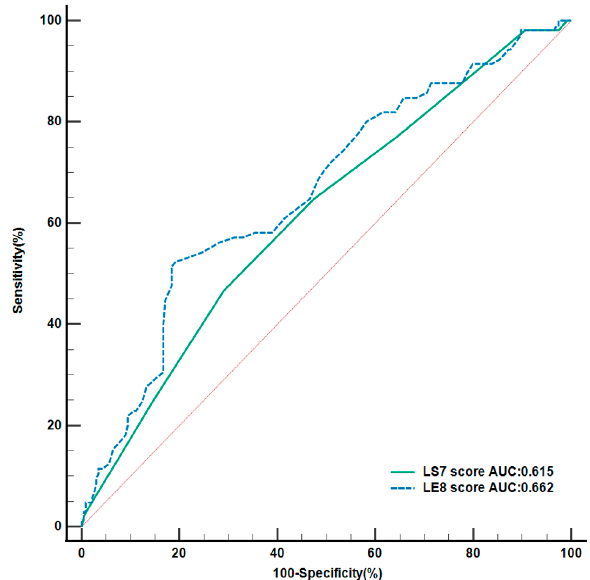
Figure 1. The ROC curve of Life’s Simple 7 and Life’s Essential 8 for predicting MACEs. LS7 Score, Life’s Simple 7 cardiovascular health score; LE8 Score, Life’s Essential 8 cardiovascular health score. 170 × 162 mm(×DPI).